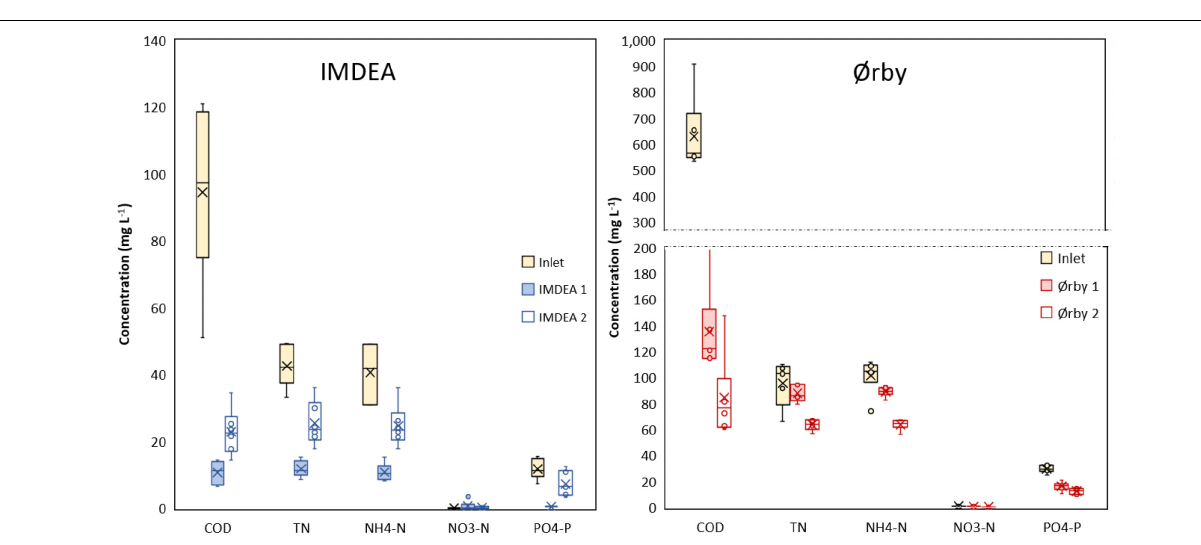
FIGURE 4 | Concentrations of COD and nutrients from both inlet and outlet for METland units operating at IMDEA (Spain) and Ørby (Denmark). Within each box, a horizontal central line denotes median values; boxes extend from the 25th to the 75th percentile of each dataset; vertical lines denote adjacent values, the minimum and the maximum; and outliers are shown as